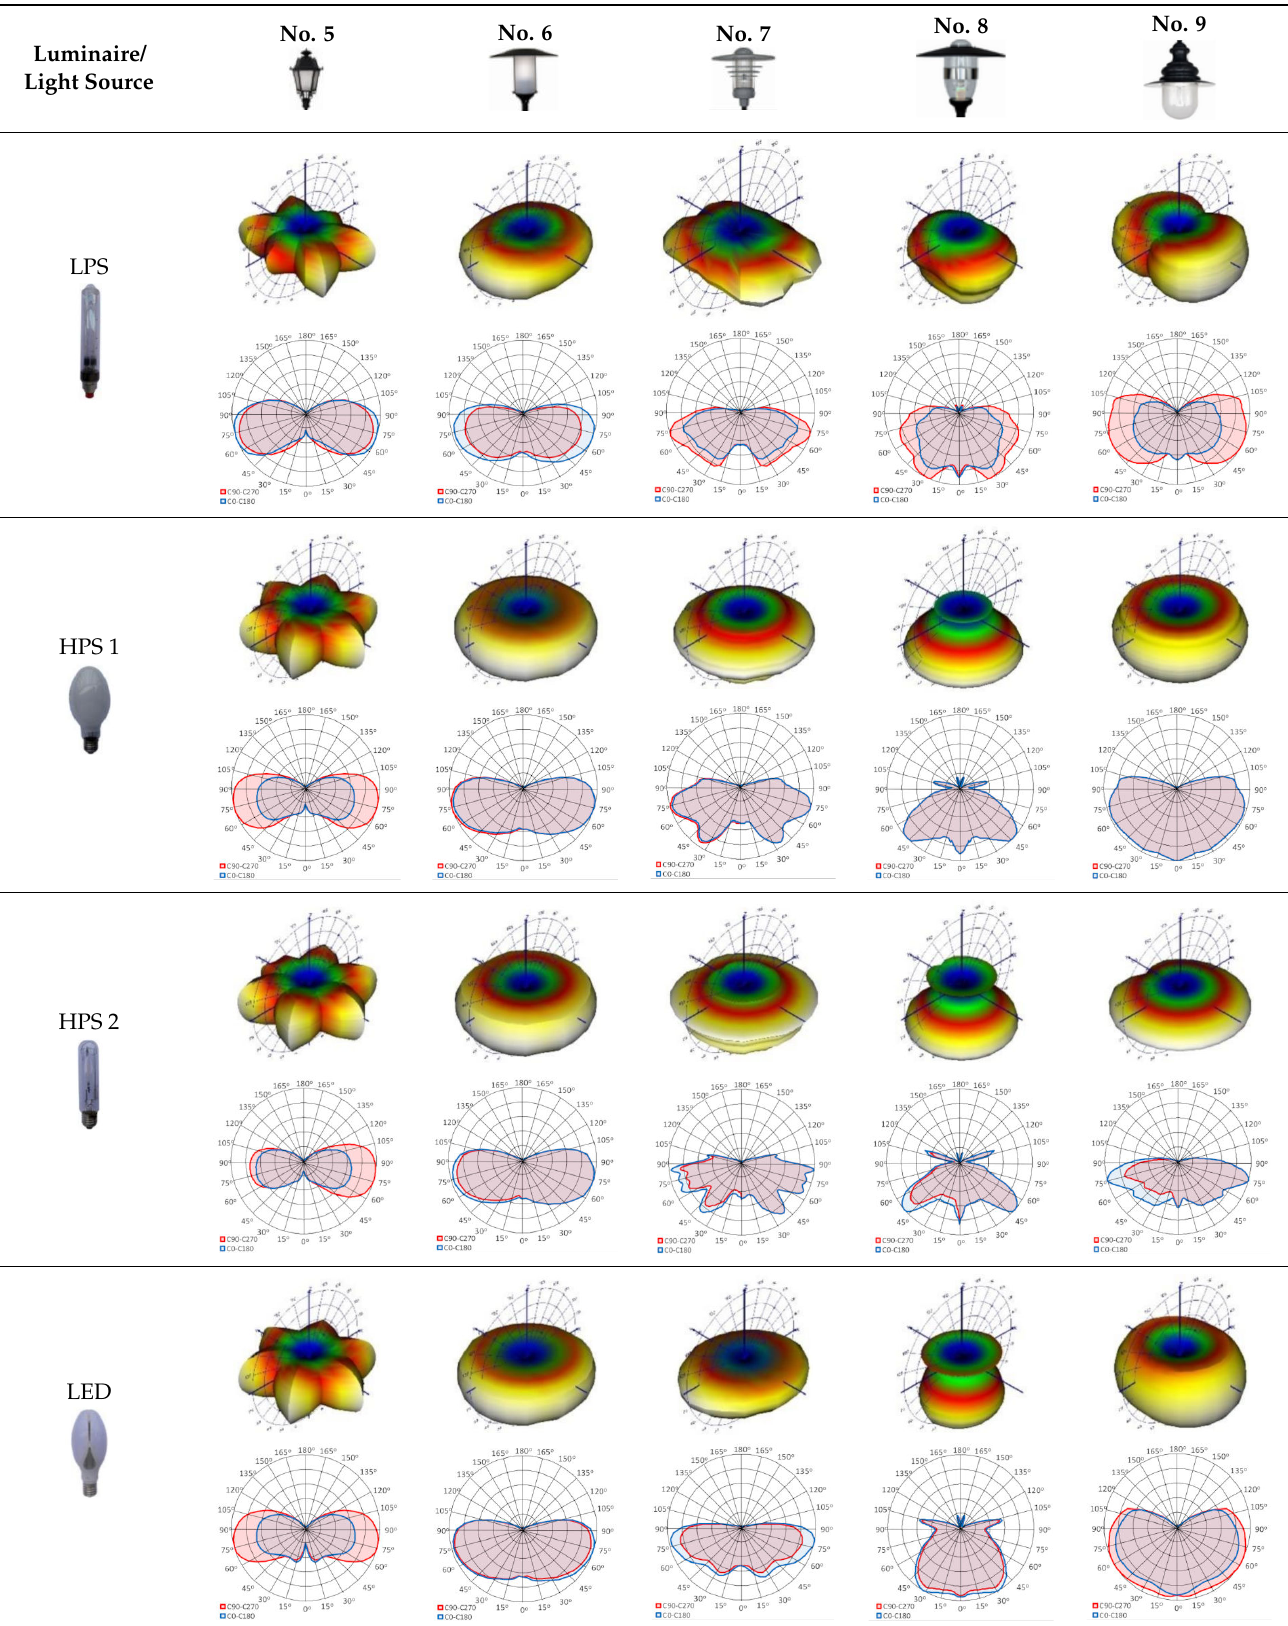
Table 4. Graphical representation of the method of light distribution by luminaires 5 to